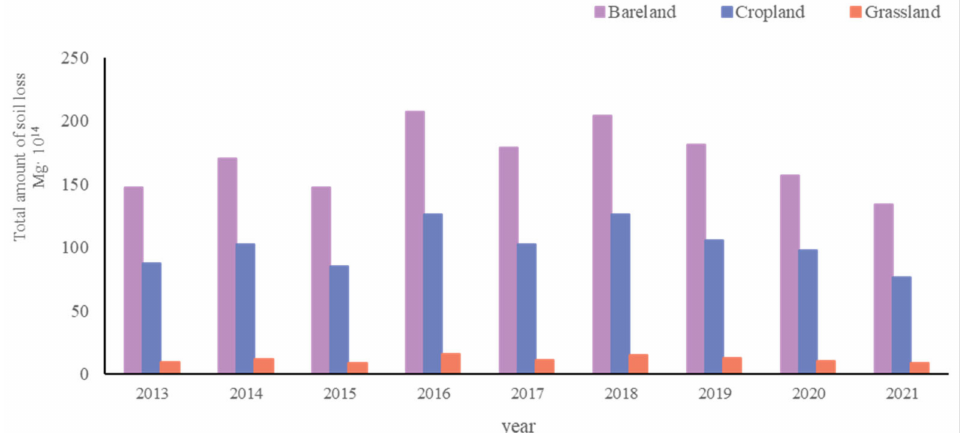
Figure 7. Total amount of soil erosion under different land use from 2013 to